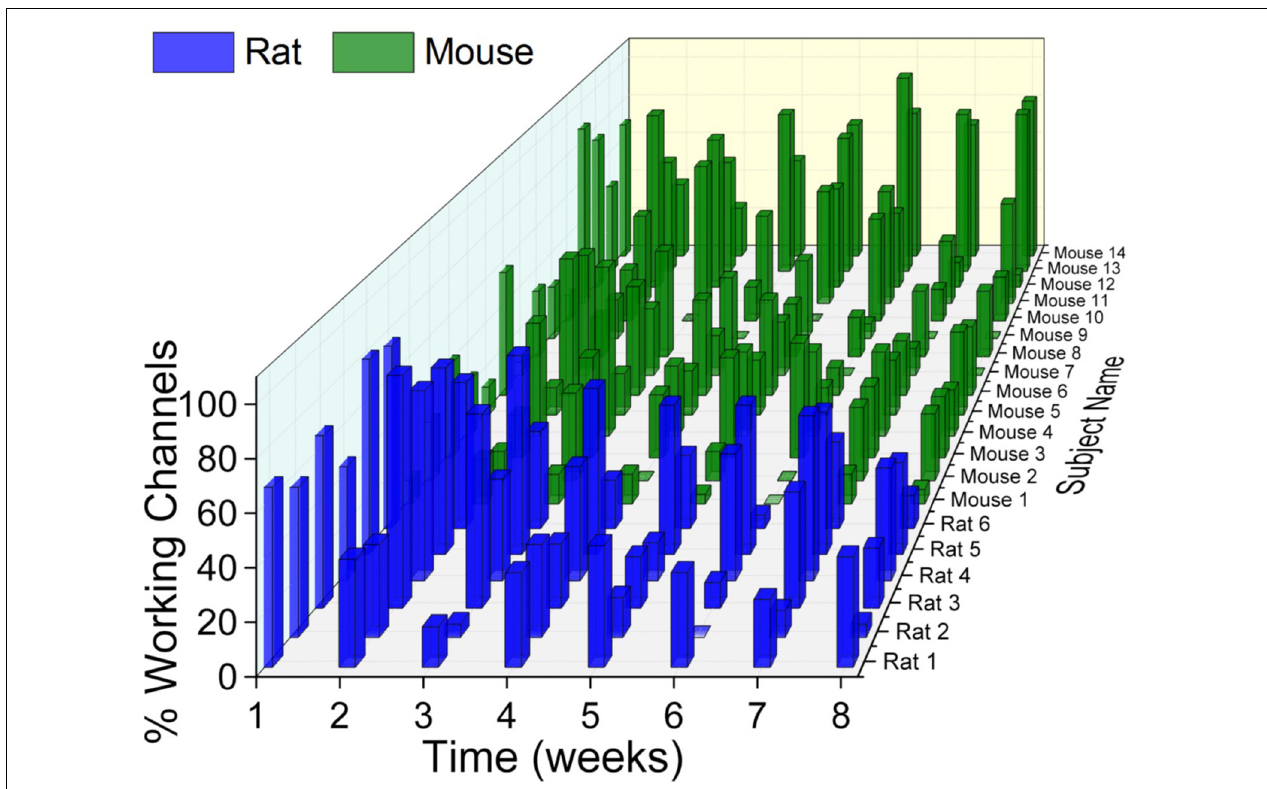
FIGURE 2 | Electrophysiological recordings variability. There was substantial variability within and across animal models as well as across time. With few exceptions, there was a universal trend for recording quality to decline over